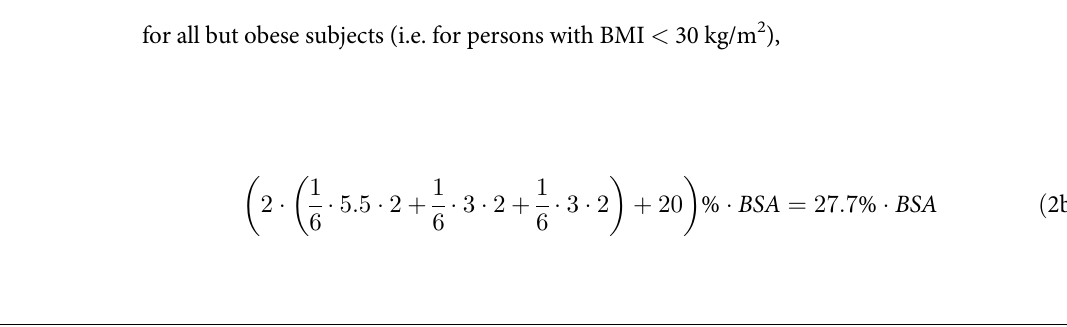
Fig 1. Illustration of subject positioning. Frontal view (A) and side view (B) of the subject in relaxed position; frontal view (C) and side view (D) of the subject in compact position.